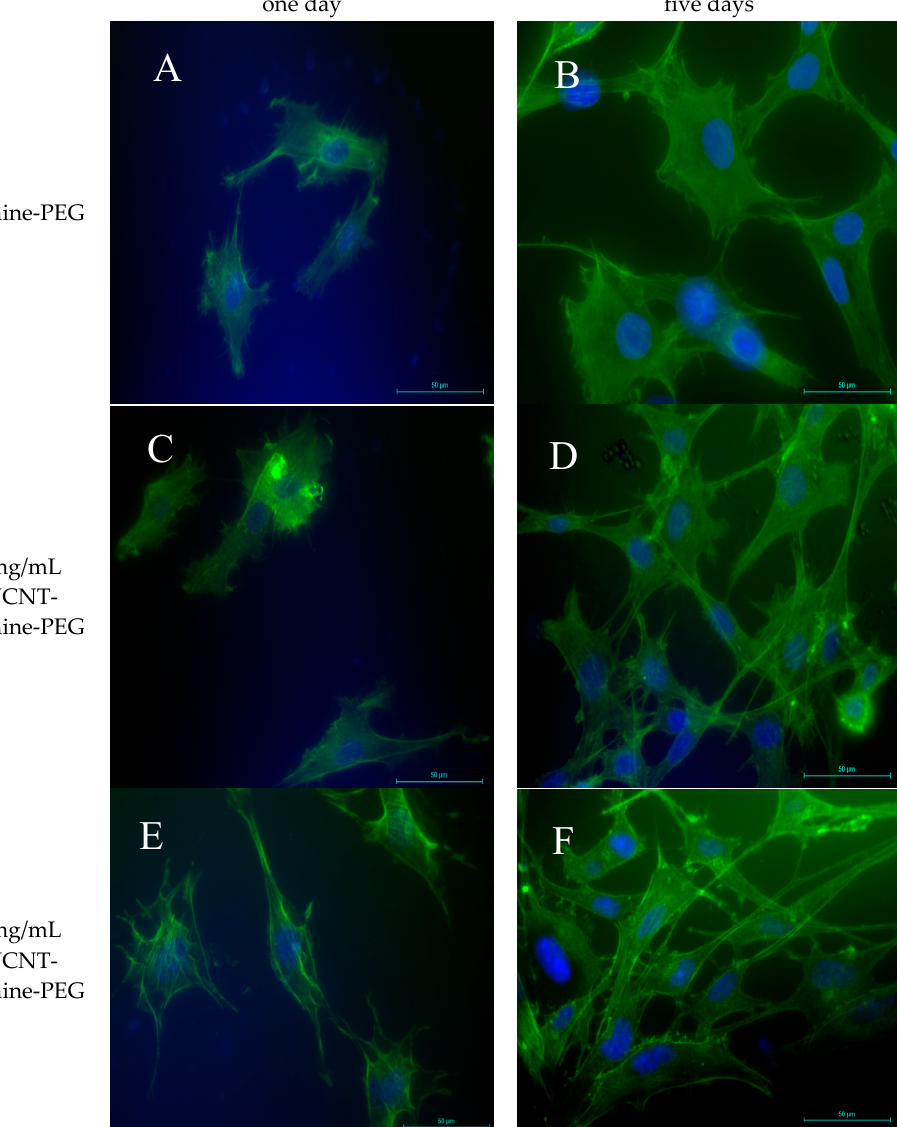
Figure 6. BMSCs cell morphology on dopamine-PEG on ( A ) day 1 and ( B ) day 5; on 0.7 mg/mL MWCNT-dopamine-PEG on ( C ) day 1 and ( D ) day 5; and on 1.4 mg/mL MWCNT-dopamine-PEG hydrogels on ( E ) day 1 and ( F ) day 5. The scale bars for all images are 20 µm. Green stands for cytoskeleton and blue stands for nucleus for all images.